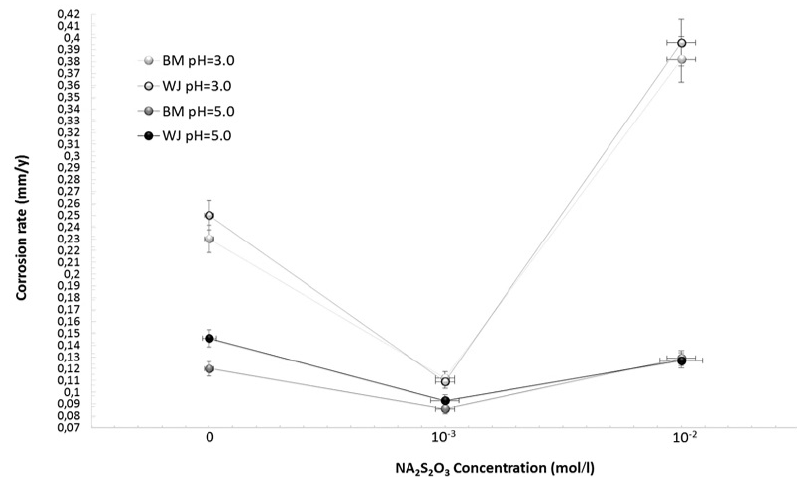
Figure 3. Average corrosion rates obtained by loss weight tests from different